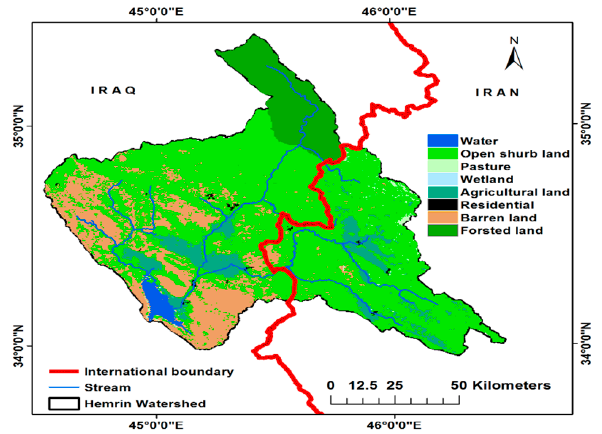
Figure 20. Senario-1 (M-1) of sediment mitigation in the Hemrin Watershed.